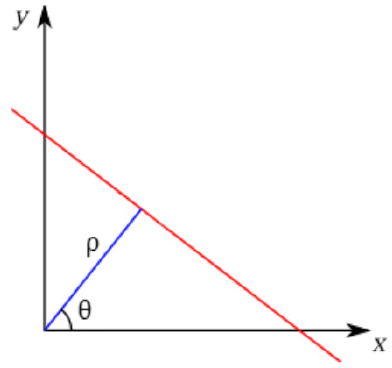
Figure 8. Graphical representation of 𝜃 and 𝜌 .